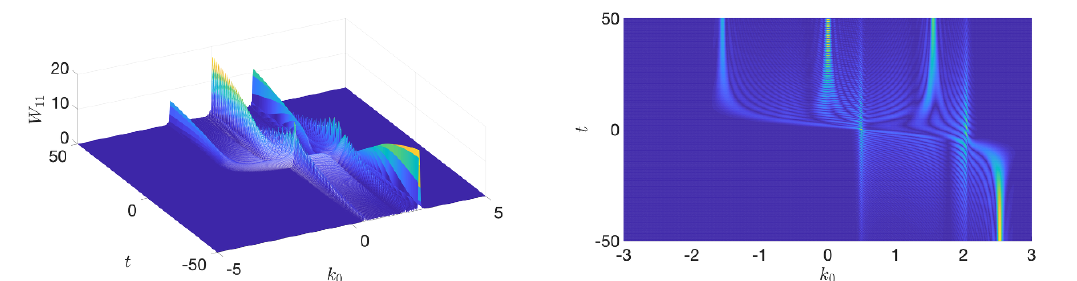
(cid:12) (cid:12) (cid:12) k (cid:12) = 0 : 4, m 1R = 0 : 5, m 2R = 2,